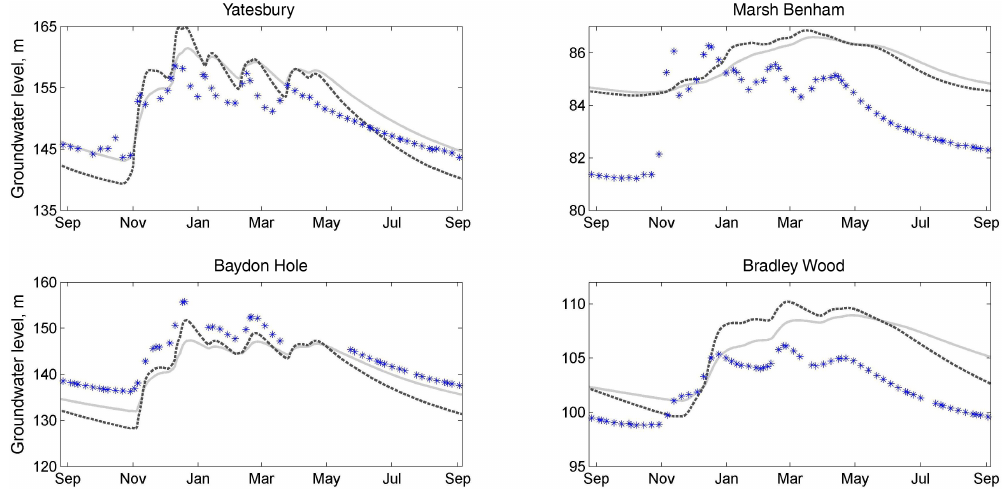
Figure 7. Water levels at four observational boreholes in the Kennet. Blue stars are observed levels, grey lines represent groundwater levels generated by JULES + WG + PDM + CHALK + GW configuration; and black dotted lines represent groundwater levels generated by JULES + WG + PDM + CHALK + GWadj